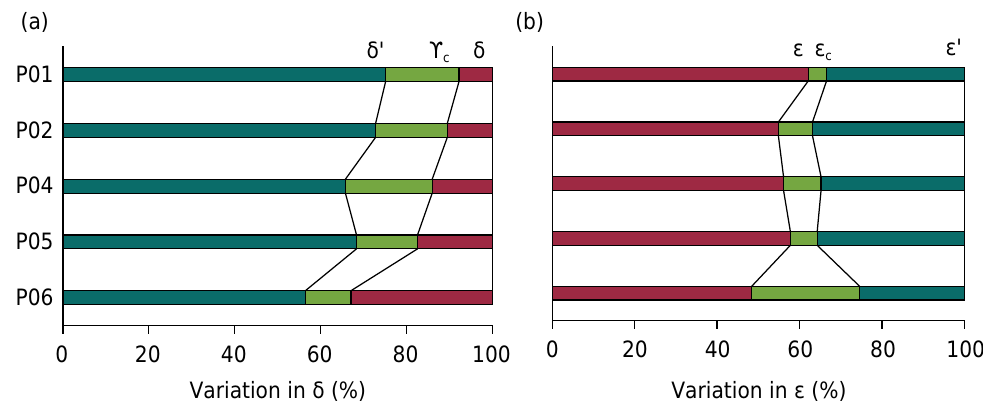
Figure 8. Variation in (a) apparent specific masses of soils dried in an oven at 105 °C (δ), as well as of saturated (δ’) and compacted (ϒ c ) soils; and in (b) void indices of soils dried in an oven at 105 °C (ε), as well as of saturated (ε’) and compacted (ε c ) soils.